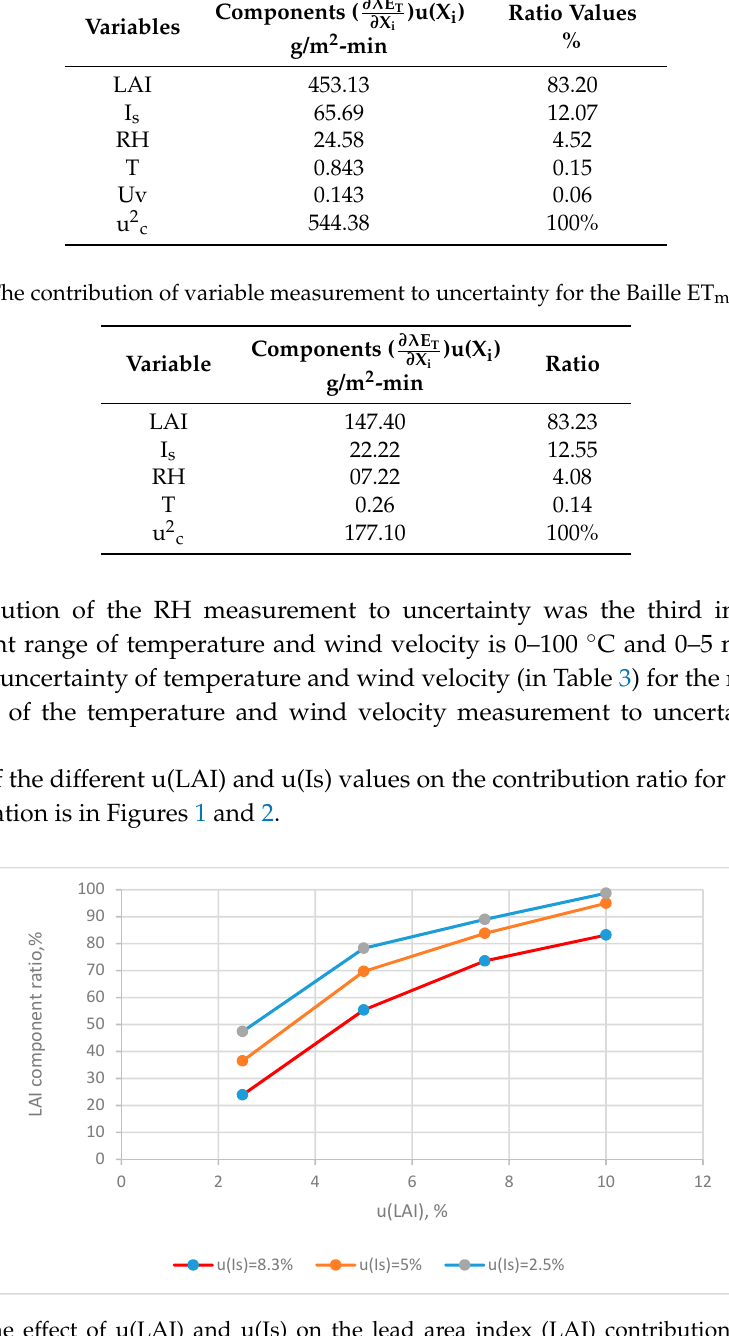
Figure 1. The effect of u(LAI) and u(Is) on the lead area index (LAI) contribution ratio for the Stanghellini equation.